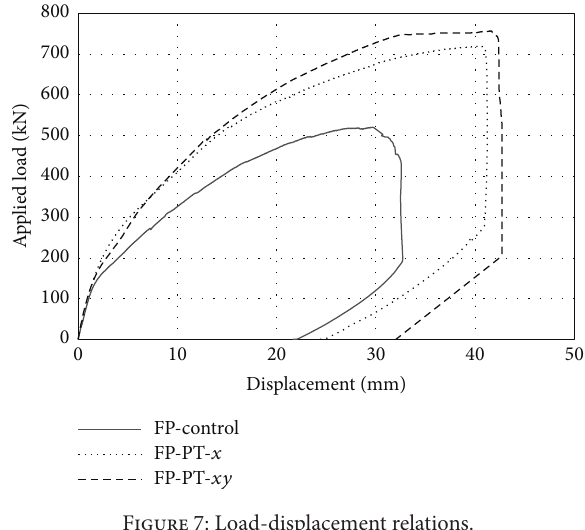
Figure 7: Load-displacement relations.